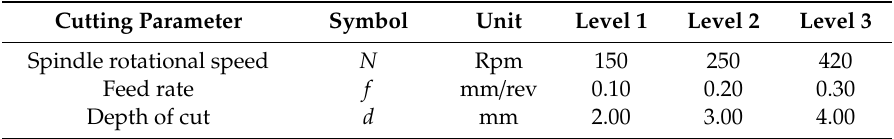
Table 3. Cutting parameters and their